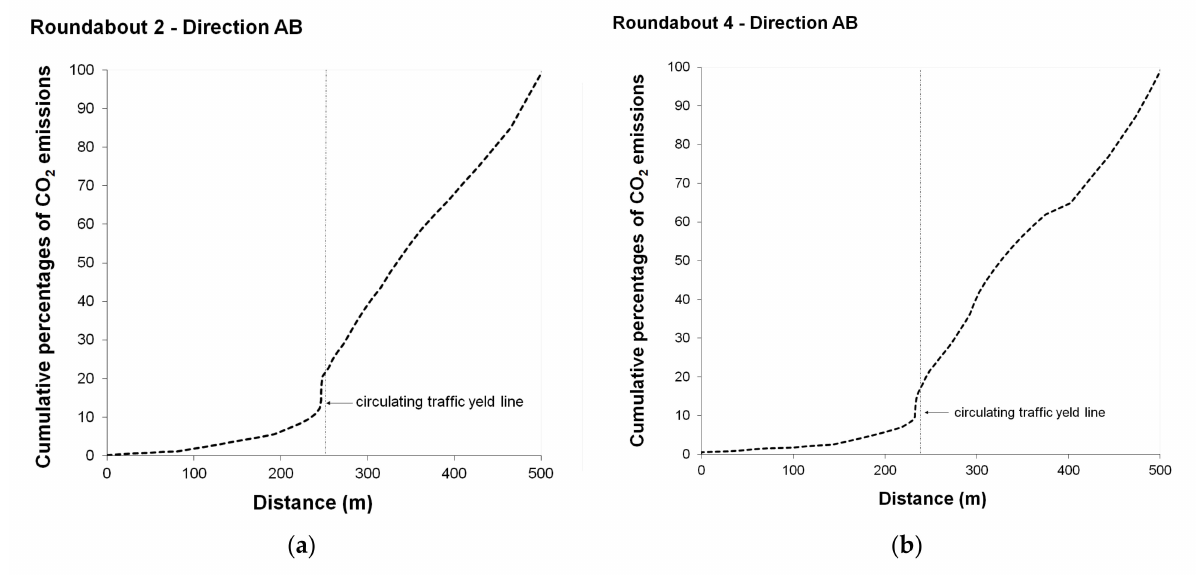
Figure 5. Spatial distribution of CO 2 emissions based on speed profiles for: ( a ) Roundabout 2 in Figure 2b and ( b ) Roundabout 4 in Figure